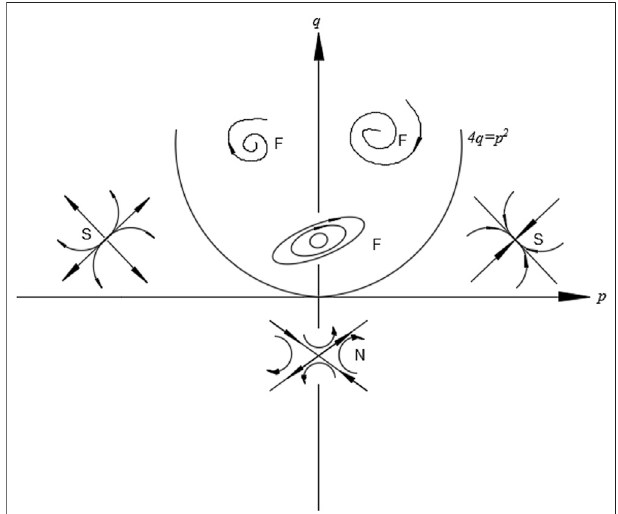
FIGURE 1 | ( p , q ) phase